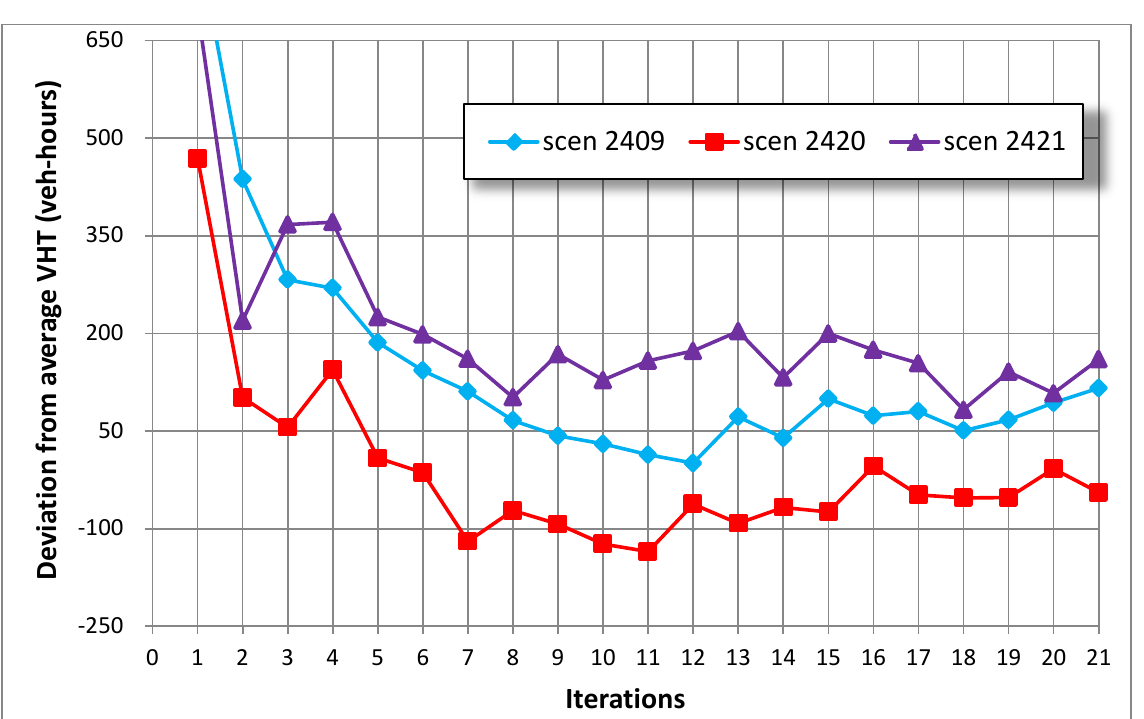
Figure 13. VHT convergence for MSA-M